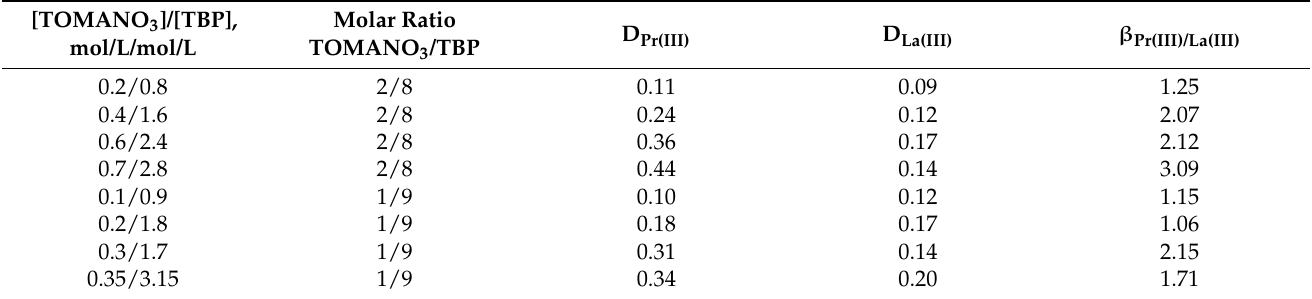
Table 3. Values D La(III) , D Pr(III) , and β La(III)/Pr(III) during SE from the solution containing 240